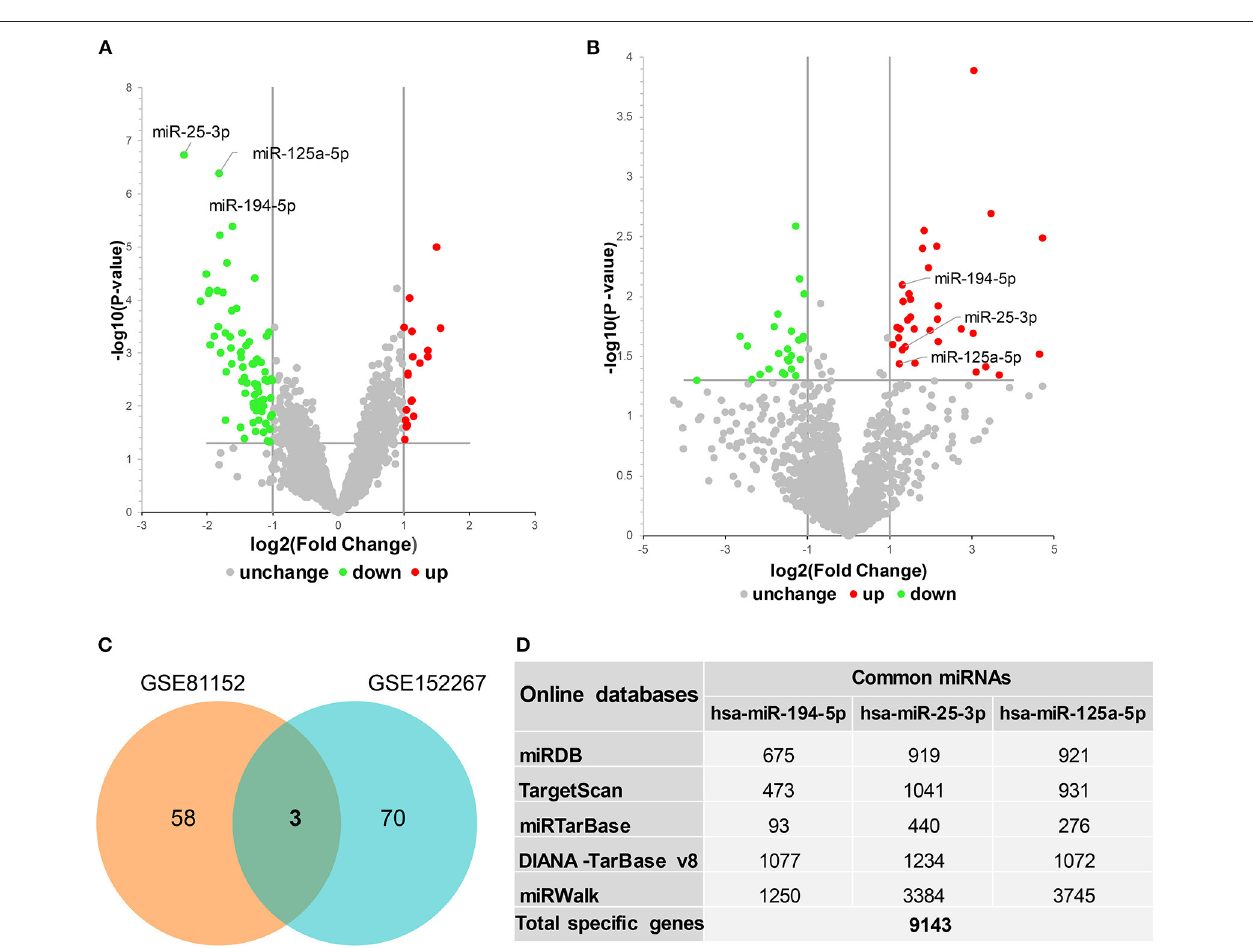
FIGURE 1 | Identification of differentially expressed miRNAs (DEMs) in major depressive disorder. (A,B) Volcano plots showing DEMs identified from GSE81152 and GSE152267 datasets, respectively. UP, upregulated; DW, downregulated; NoDiff, no differential expression. (C) Venn diagram showing the intersected DEMs between GSE81152 and GSE152267 datasets. (D) The prediction of target genes of these common DEMs.